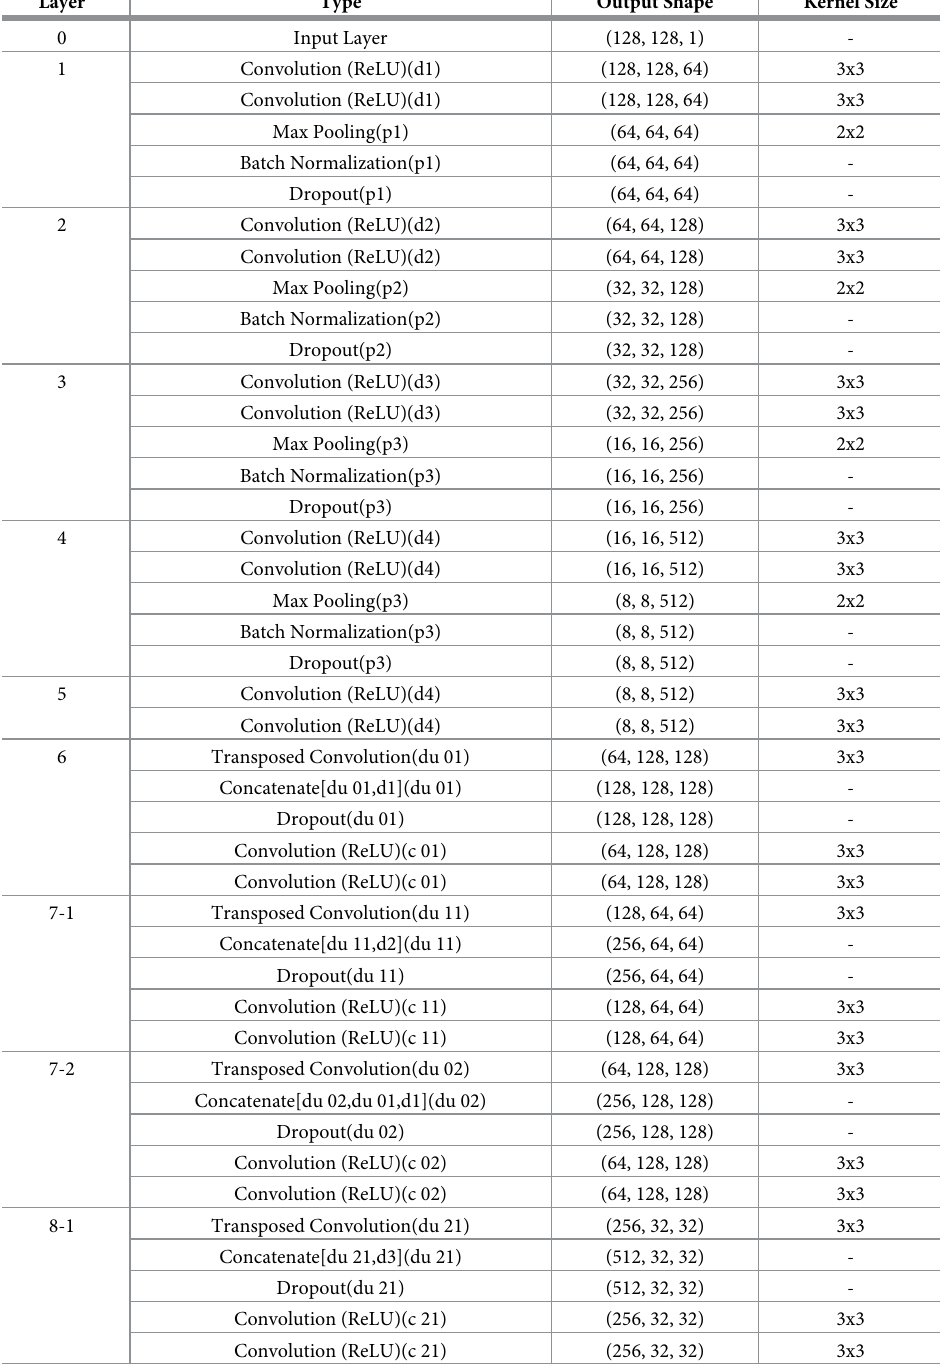
Table 5. 2D U-Net++ model structure for tumor